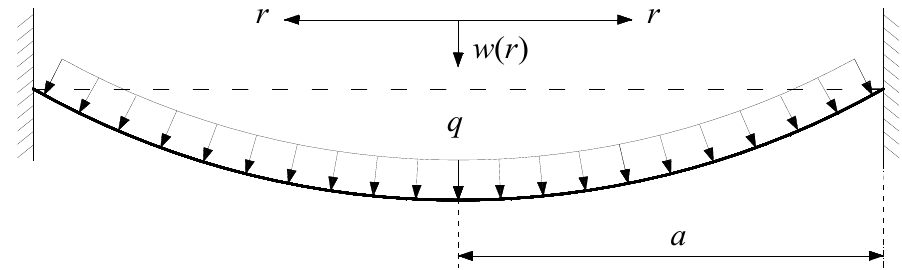
Figure 3. Sketch of circular membrane under uniformly distributed gas pressure.